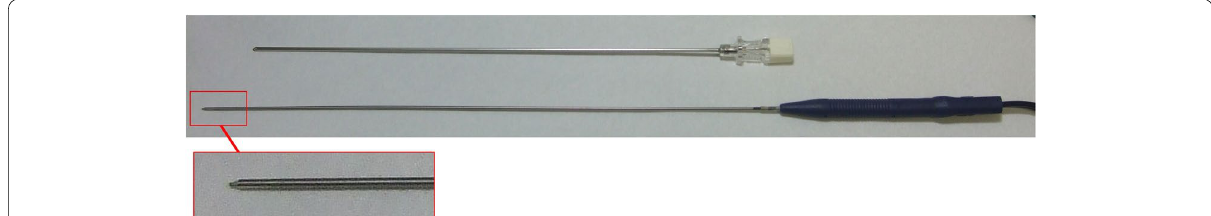
Fig. 1 The radiofrequency thermocoagulation system. A 16-gauge spine needle is used as a cannula through which a 1-mm-diameter radiofrequency thermocoagulation probe is placed